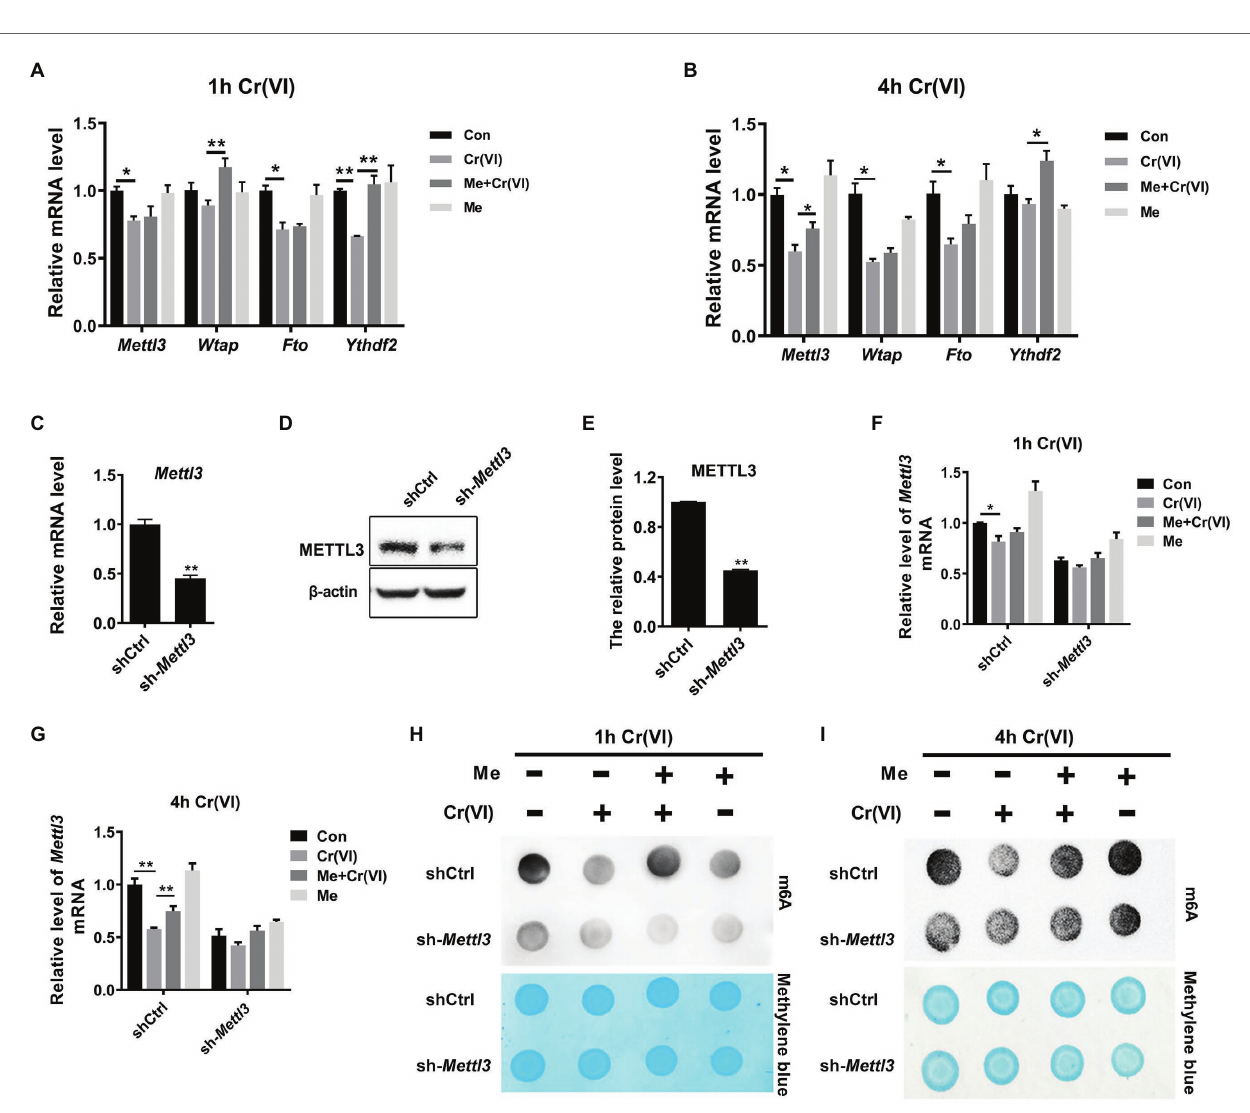
FIGURE 8 | Melatonin attenuated Cr (VI)-induced decrease of the RNA m 6 A modification level via METTL3 in SSCs/progenitors. (A,B) qPCR analysis of Mettl3 , Wtap , Fto , and Ythdf2 in the control, Cr (VI), melatonin + Cr (VI), and melatonin-treated SSCs/progenitors. Of these, Cr (VI) treatment lasted for 1 h (A) or 4 h (B) . (C,D) qPCR (C) and Western blot analysis (D) of METTL3 in the scramble control and Mettl3 -shRNA SSC/progenitor group. β -actin is used as a loading control. (E) The METTL3 band intensities relative to β -actin in the scramble control and Mettl3 -shRNA SSC/progenitor group. (F,G) qPCR analysis of Mettl3 in the scramble control and Mettl3 -shRNA SSCs/progenitors treated with vehicle, Cr (VI), melatonin + Cr (VI), or melatonin. Of these, Cr (VI) treatment lasted for 1 h (F) or 4 h (G) . (H,I) The m 6 A dot-blot assay showing the global RNA m 6 A modification levels in the scramble control and Mettl3 - shRNA SSCs/progenitors treated with vehicle, Cr (VI), melatonin + Cr (VI), or melatonin. Of these, Cr (VI) treatment lasted for 1 (H) or 4 h (I) . Methylene blue is used as a loading control to eliminate the difference in mRNA amount. Data are presented as the mean ± SEM of three independent experiments. * p < 0.05; ** p <